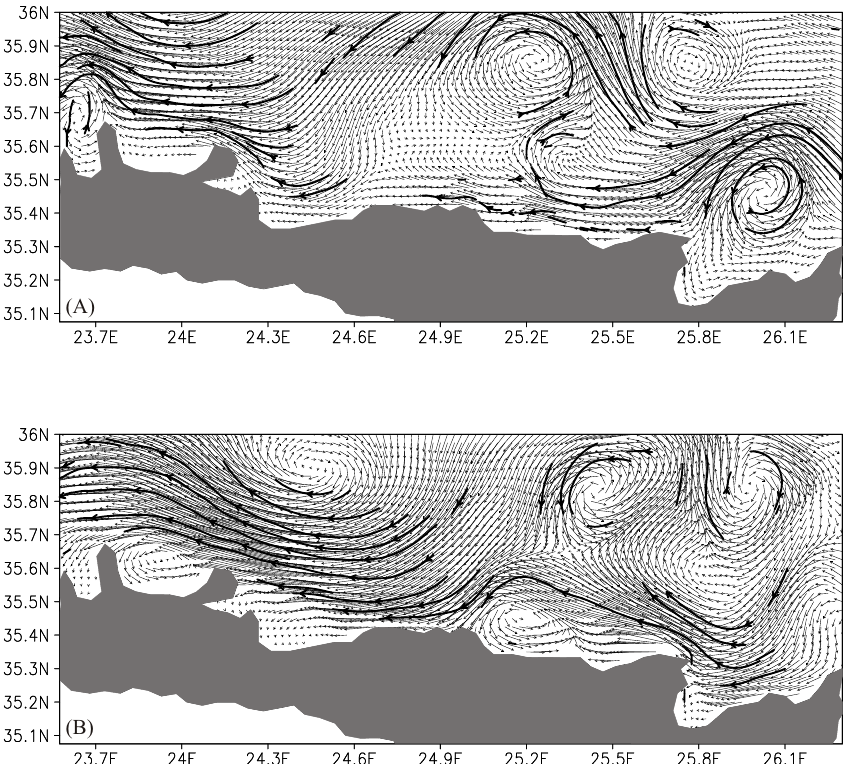
Fig. 8. (a) Winter (11–20 March) subsurface (30m) circulation pattern for the Cretan Sea, corresponding to SI-AL run (third year). (b) Same as (a) but for summer (11–20